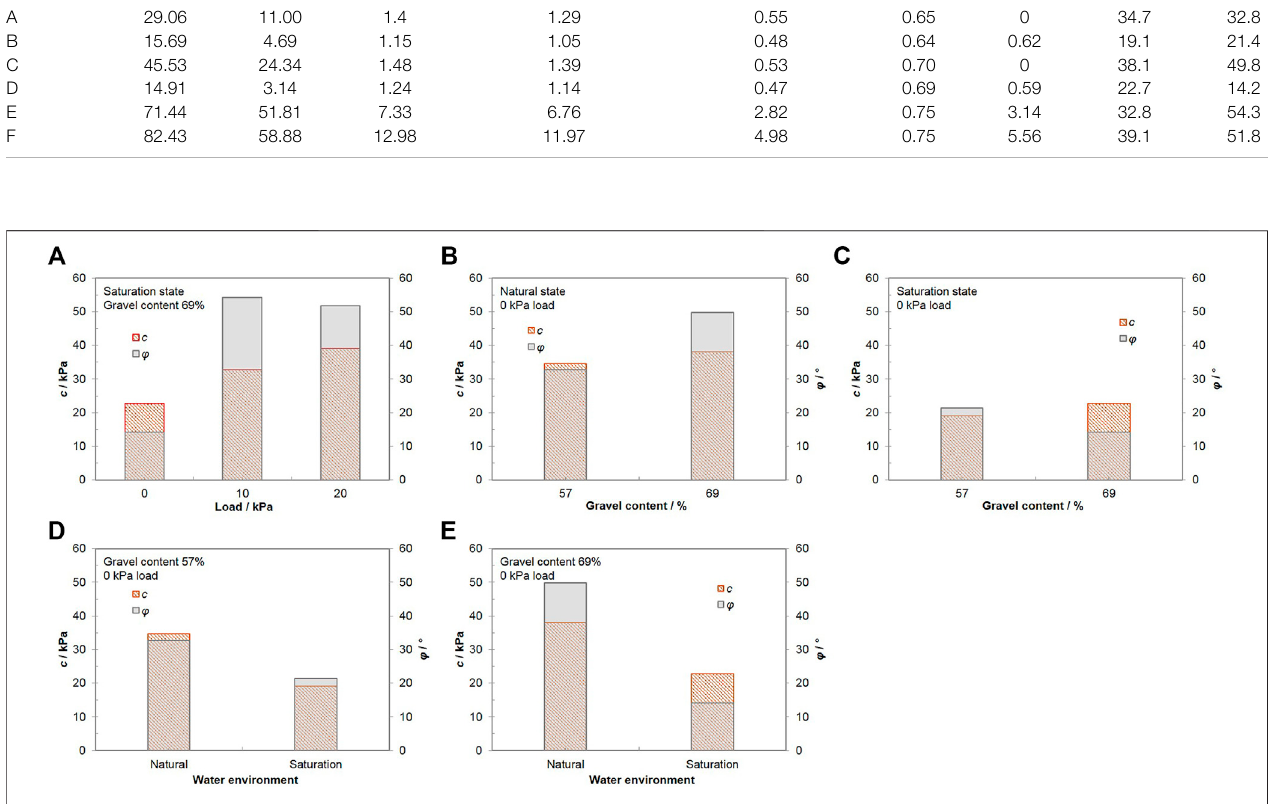
FIGURE 6 | The relationship between shear strength and in fl uencing factors (A) relationship with load (B) relationship with gravel content in natural state (C) relationship with gravel content in saturation state (D) relationship with water environment at low gravel content (E) relationship with water environment at high gravel